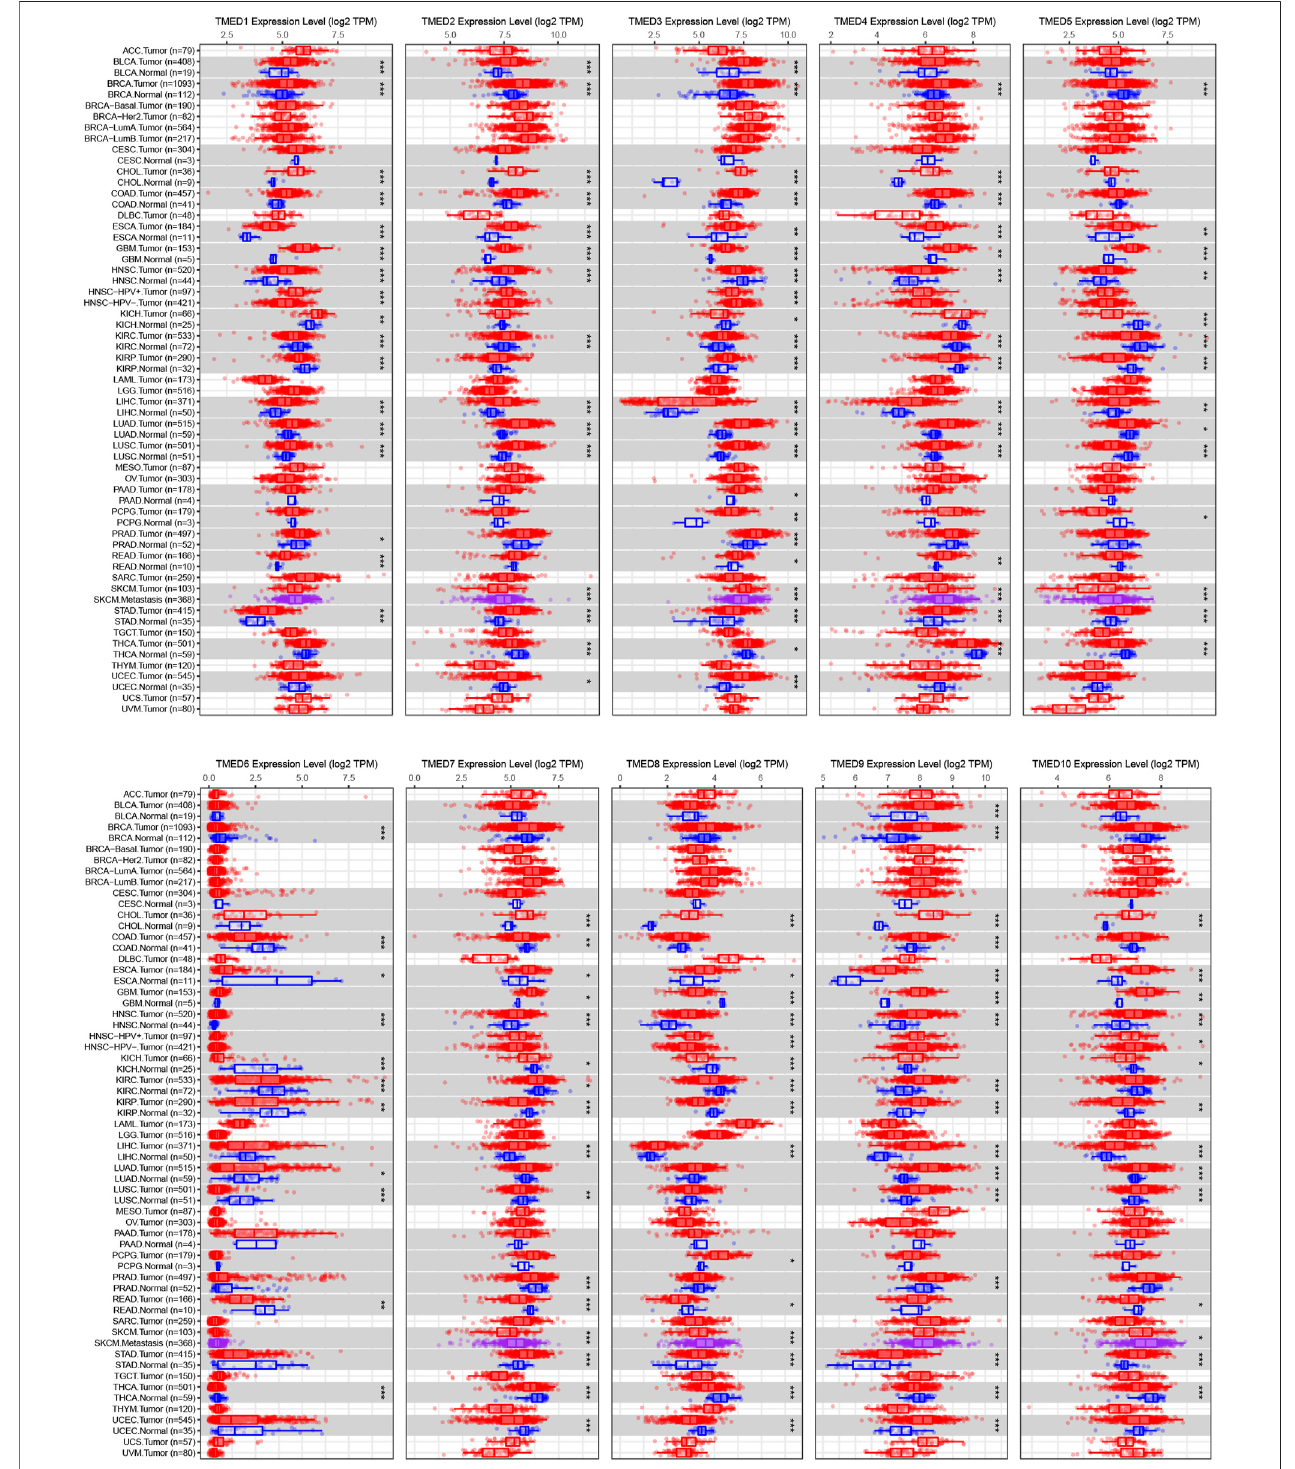
FIGURE1| ExpressionlevelsoftheTMEDfamilyindifferenttypesoftumor tissues andnormaltissuesfromtheTIMER2.0database.(* p -value < 0.05,** p -value < 0.01, *** p -value < 0.001).